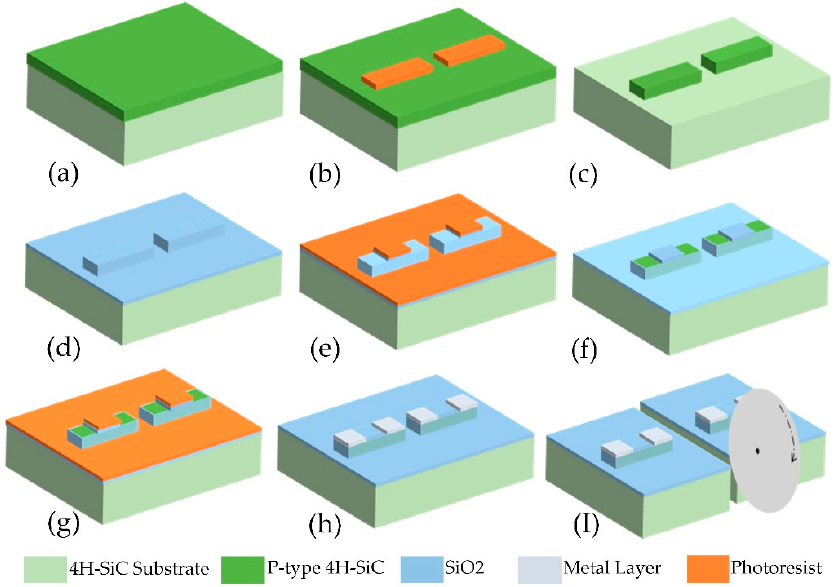
Figure 3. The processing flow of 4H-SiC cantilever beam structure. ( a ) P-type 4H-SiC epitaxial wafer. ( b ) Piezoresistive structures were patterned by the first lithography. ( c ) Resistance stripes were etched using reactive ion etching (RIE). ( d ) The SiO 2 isolation layer was grown by plasma-enhanced chemical vapor deposition (PECVD). ( e ) The ohmic contact hole was patterned by the second lithography. ( f ) The ohmic contact hole was opened in buffered HF solution. ( g ) Metal structures were patterned by the third lithography. ( h ) Ni 200 Å/Ti 500 Å/Al 3000 Å/Au 3000 Å were deposited and then patterned by stripping the AZ6130 photoresist in acetone. ( I ) The cantilever beam structures were prepared by using an automatic dicing saw.